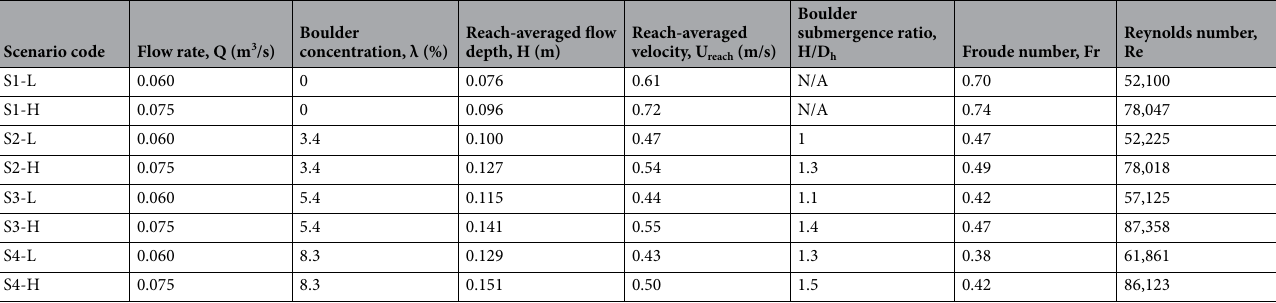
Table 1. Description of the experimental